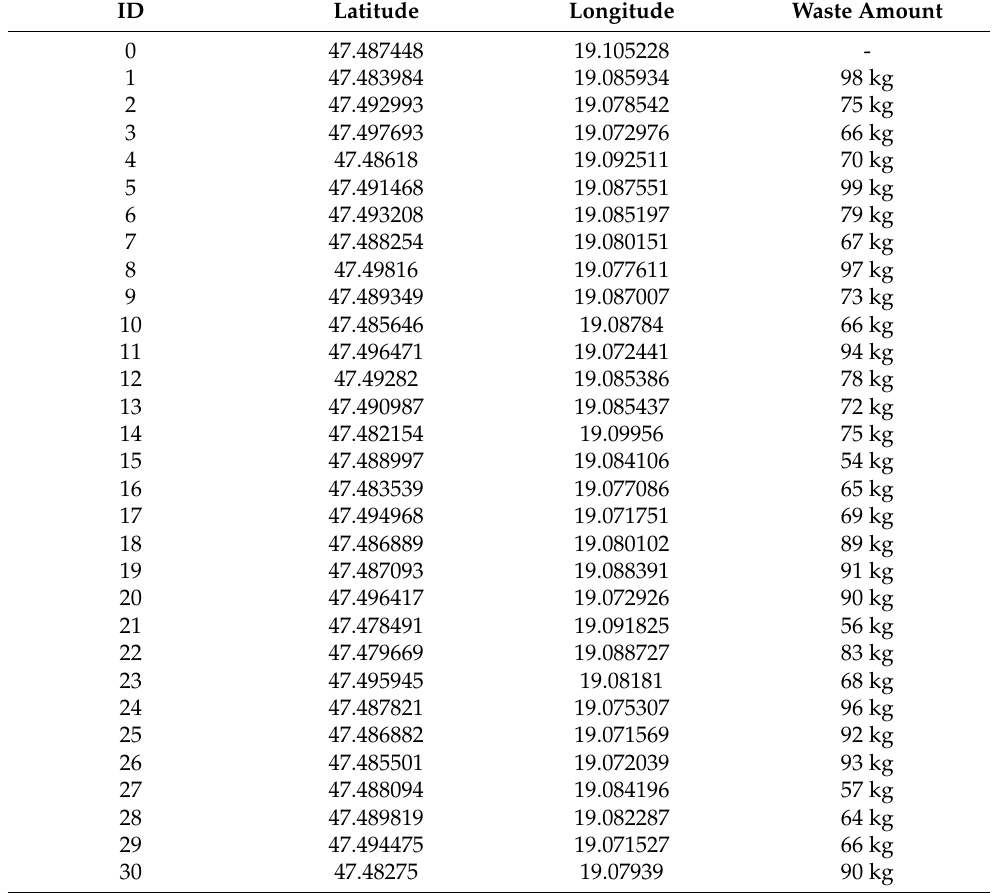
Table 4. Bins’ locations and waste